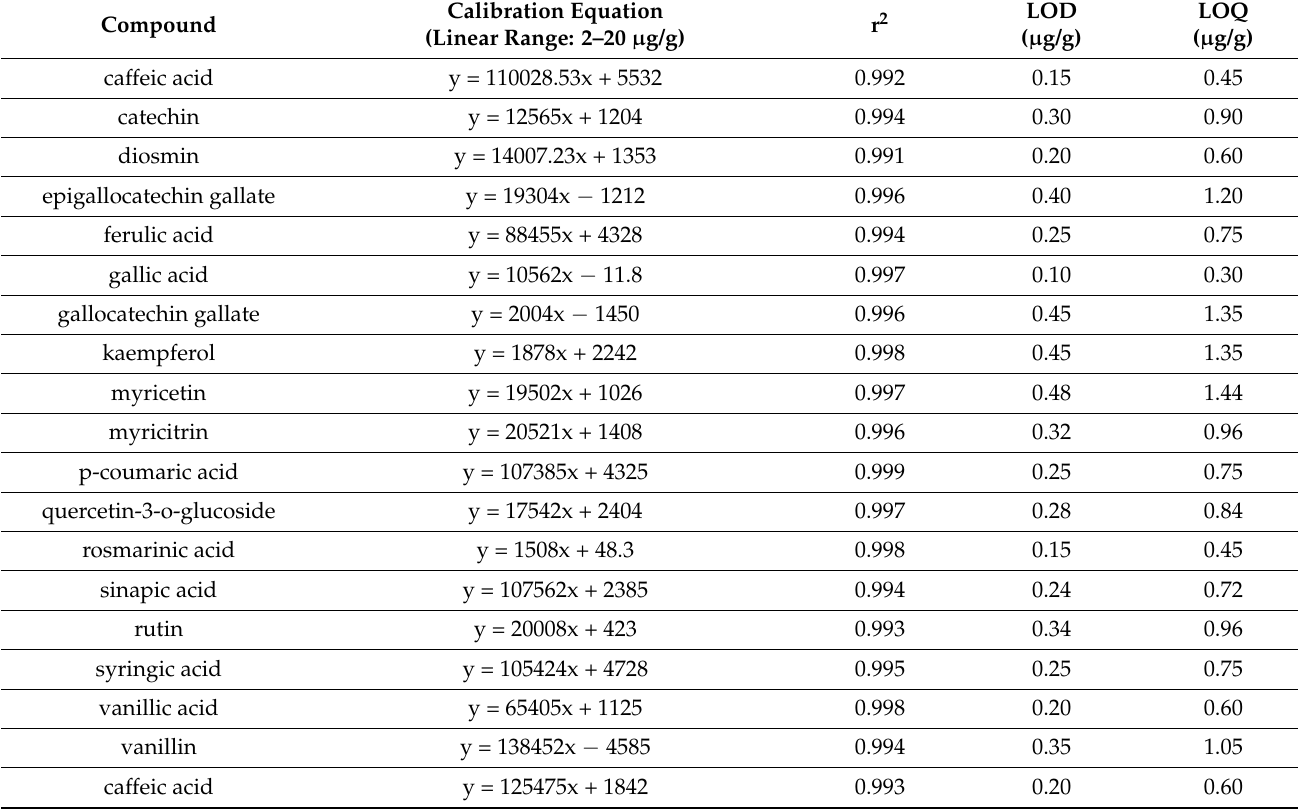
Table 1. HPLC-DAD method analytical parameters.